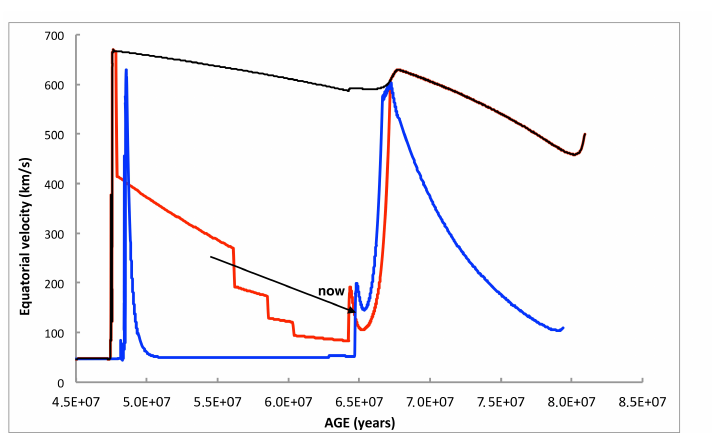
Figure 5. Evolution with age of the equatorial velocity of the gainer of a (6.36 M (cid:12) + 2.7 M (cid:12) ) binary with an initial period of 1.89745 days. Black line: tides and magnetic braking are not at work; red line: tides act alone; blue line: tides and magnetic braking act together.